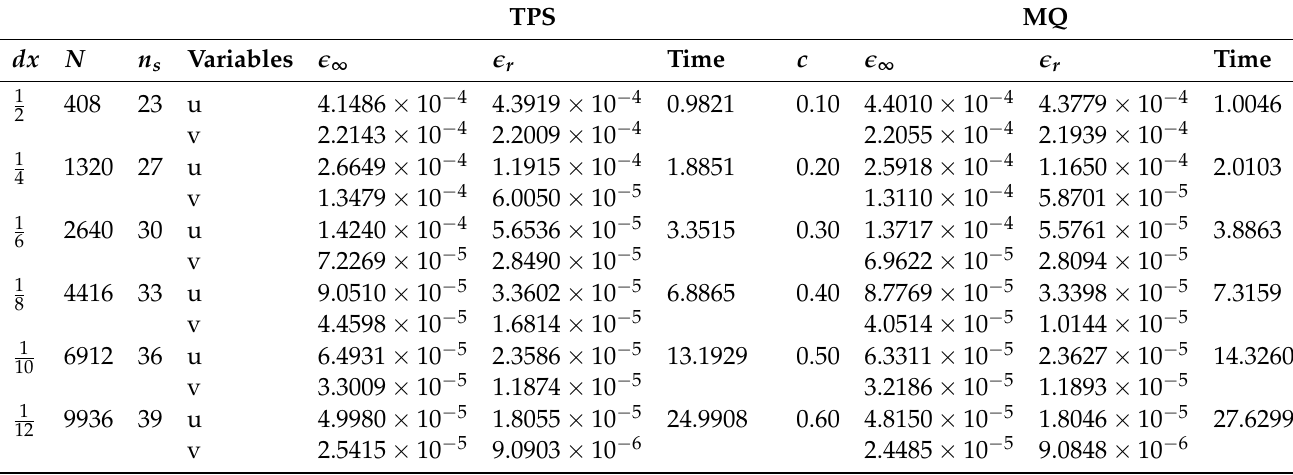
Table 1. Error estimates and CPU times of Example 1 by letting τ = 0.5 ( dx ) 2 for different values of dx , and stencil size n s . TPS MQ